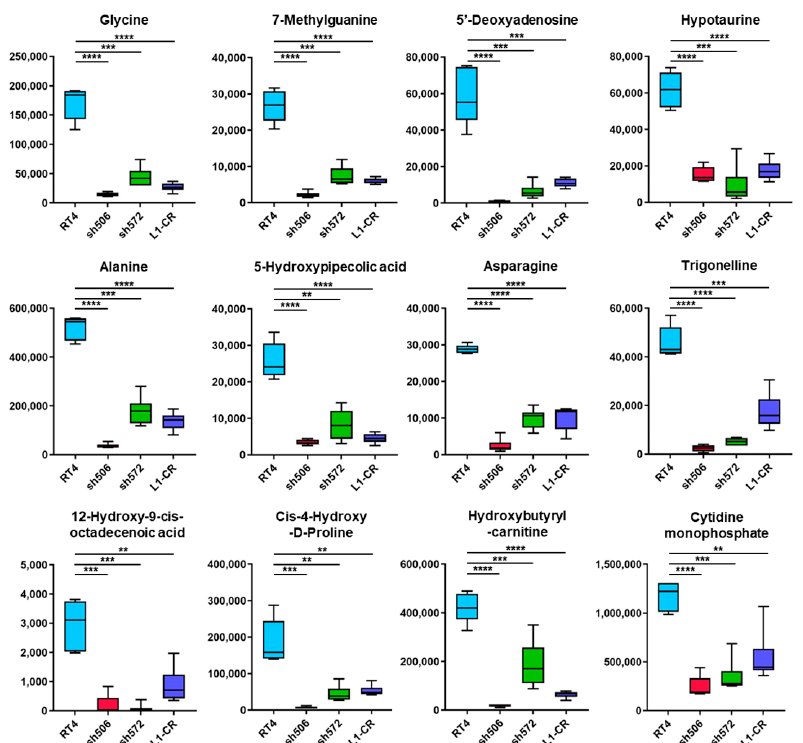
Figure 4. Boxplots showing the distribution of normalized peak area counts from the MS analysis for top significant metabolites (OL1 and OL2a ontology levels) based on the volcano plot in Supplementary Figure S2B that differentiate RT4 cells and three ALDH1L1 depleted clones. The values on the y axis represent normalized peak area counts. FDR-corrected p values are: **** p < 0.0001; *** p < 0.001; ** p < 0.01. Non-corrected and Bonferroni-corrected p values for the pairwise comparison of RT4 cells and each clone are shown in Supplementary Table S2 (metabolites from Figure 4 are highlighted in the table).